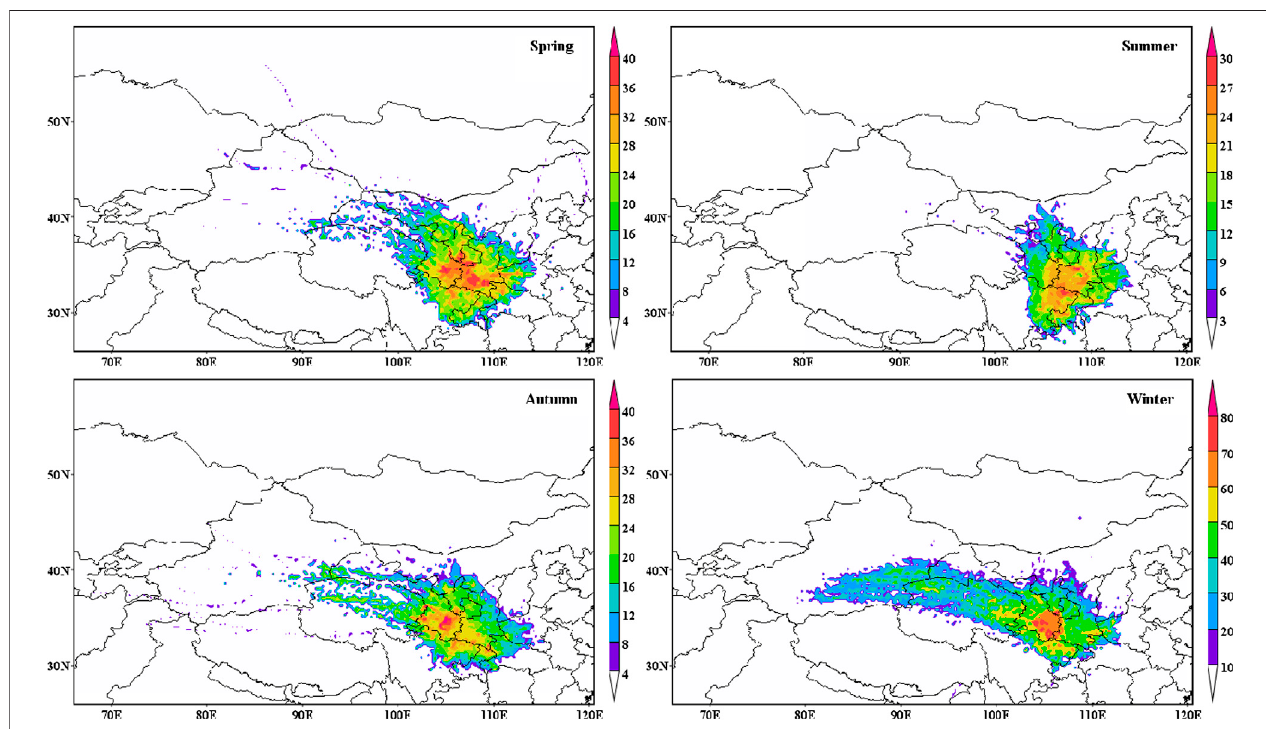
FIGURE 9 | Weighted concentration weighted trajectory distribution of PM 2.5 in different seasons ( μ g m − 3 ).